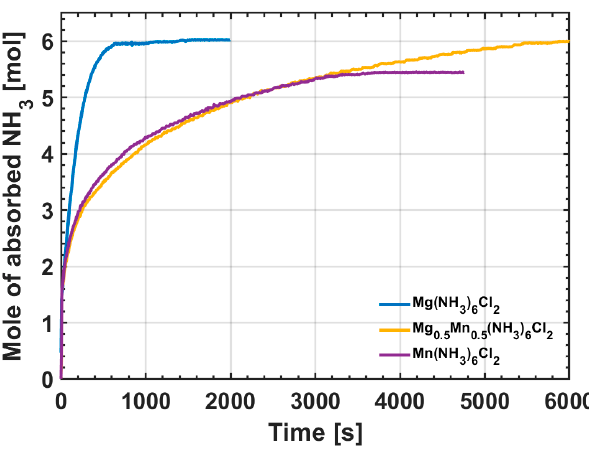
Figure 7. NH 3 absorption processes of Mg(NH 3 ) 6 Cl 2 (blue), Mg 0.5 Mn 0.5 (NH 3 ) 6 Cl 2 (yellow) and Mn(NH 3 ) 6 Cl 2 (purple).